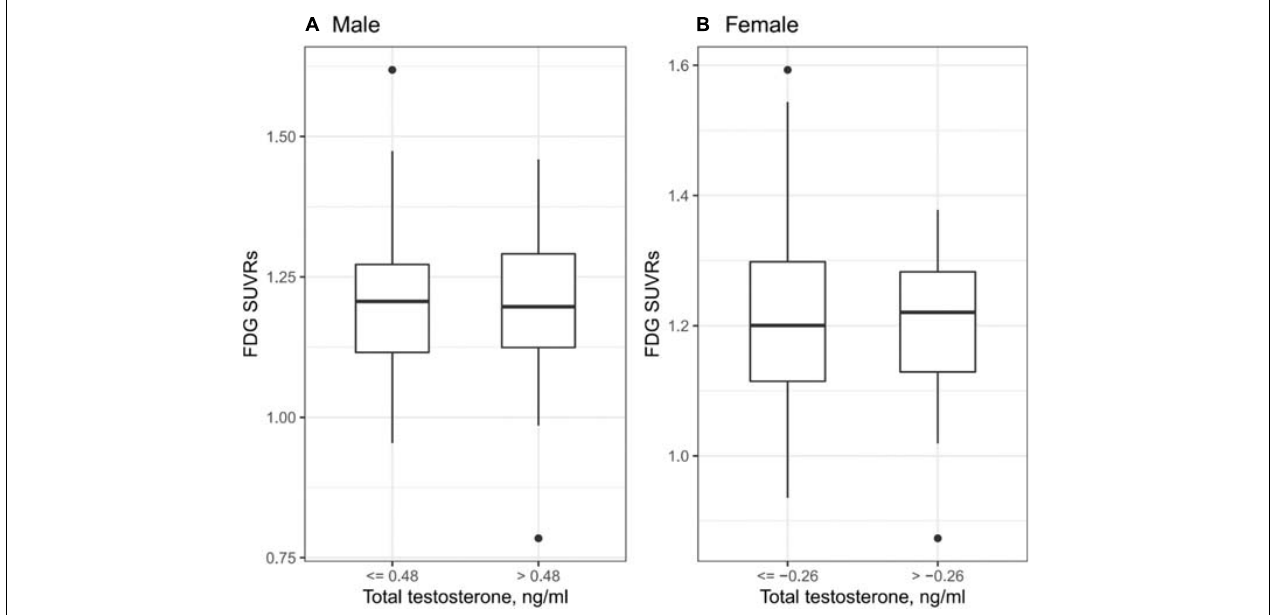
FIGURE 2 | Cross-sectional relationship between plasma testosterone and FDG SUVRs. (A) In males, there was no statistically significant relationship between plasma total testosterone levels and FDG SUVRs ( p > 0.05). (B) In females, there was no statistically significant relationship between plasma total testosterone levels and FDG SUVRs ( p > 0.05).